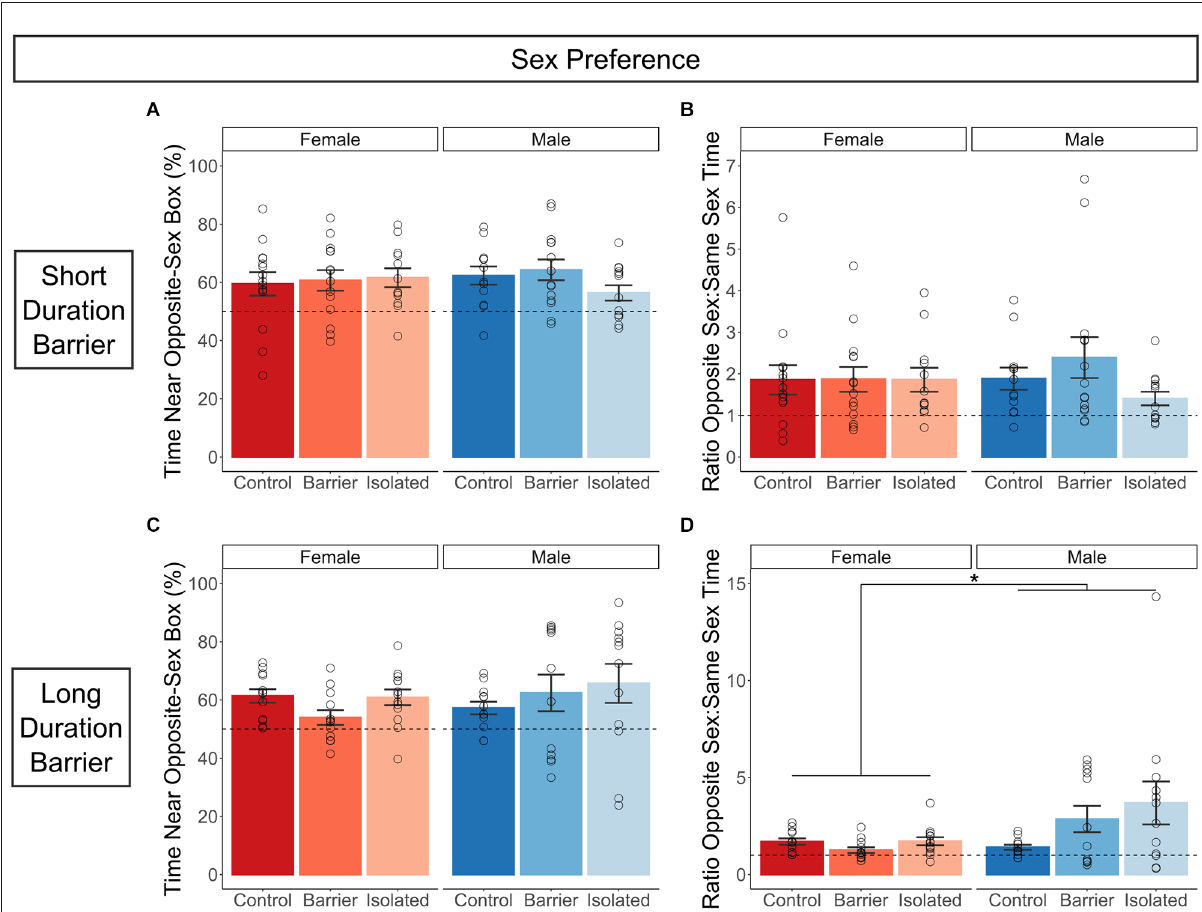
FIGURE7 Juvenile play deprivation has no effect on sex preference in adulthood. Quantification of the percentage (A) and ratio (B) of time spent near the opposite-sex stimulus box compared to time spent near the same-sex stimulus box in the short duration barrier study. The same measures are shown in (C,D) for the long duration barrier study. Bars indicate group means ± SEM, and open circles represent data from individual rats. * p < 0.05, n = 12–14 per